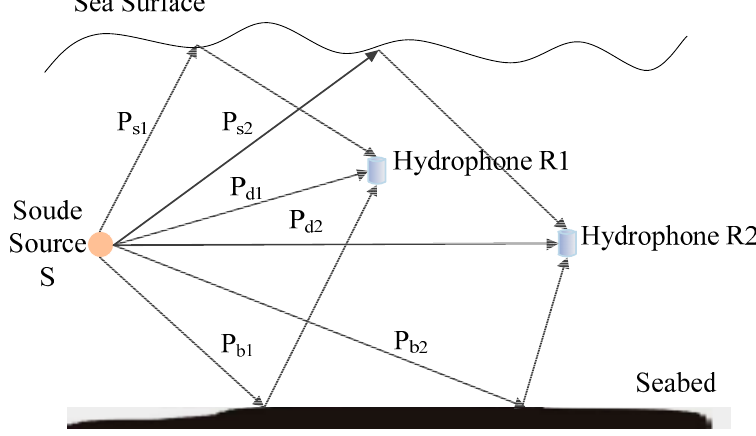
Figure 3. Simplified underwater multipath propagation model.